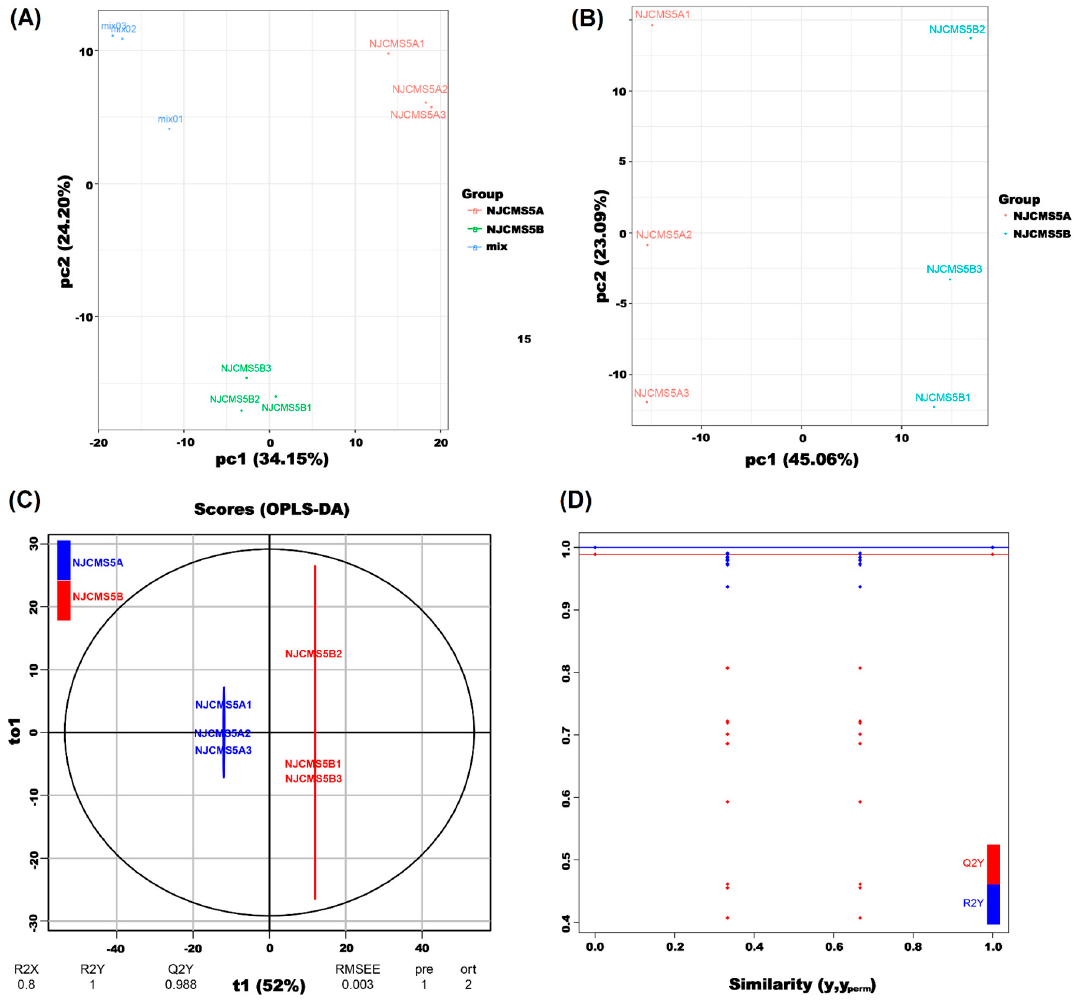
Figure 2. Principal component analysis (PCA) and orthogonal projections to latent structures-discriminant analysis (OPLS-DA). ( A ) PCA score scatter plot for mass spectrum data of NJCMS5A, NJCMS5B, and mix (quality control sample). The x axis and y axis indicate the PC1 and PC2, respectively; ( B ) Score scatter plot of the PCA model for the NJCMS5A versus NJCMS5B. The x axis and y axis indicate the PC1 and PC2, respectively; ( C ) Score scatter plot of the OPLS-DA model for